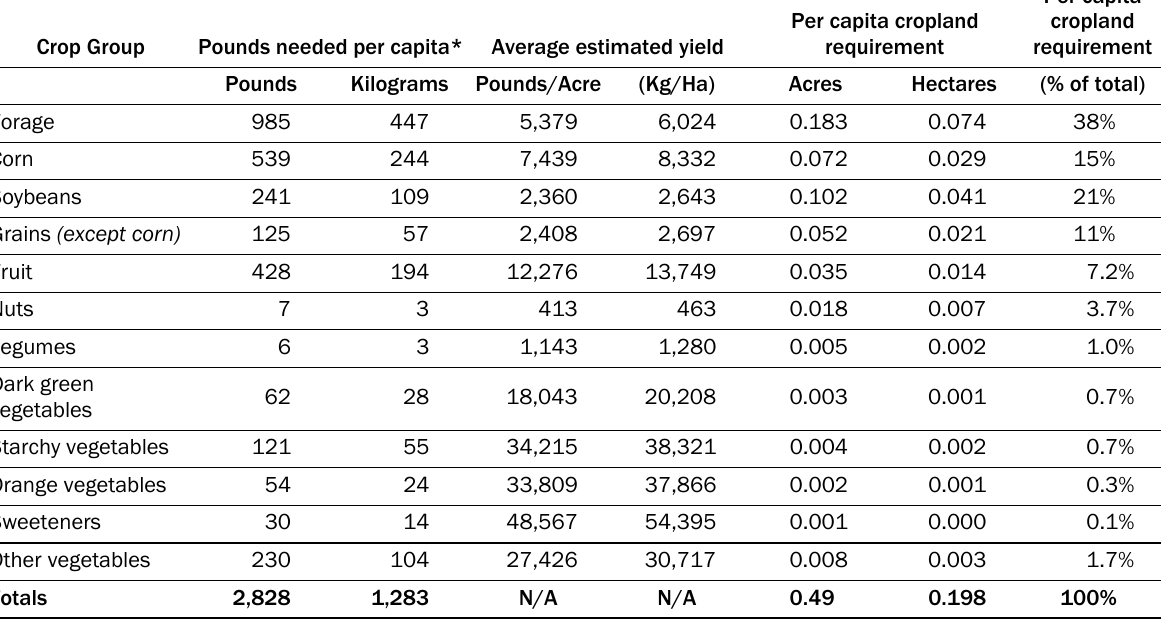
Table 3. Estimated Yields by Crop Group